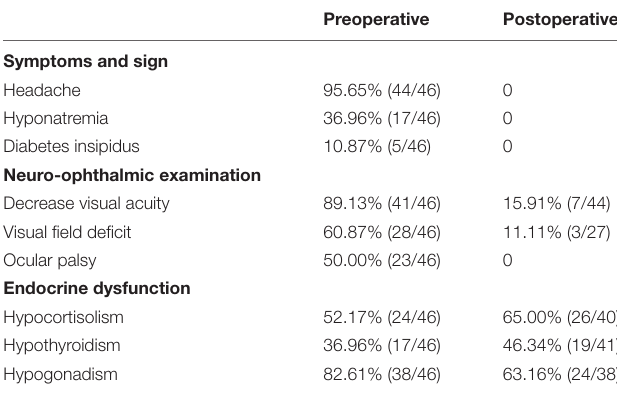
TABLE 4 | Baseline characteristics of patients with ischemic PA between preoperative and